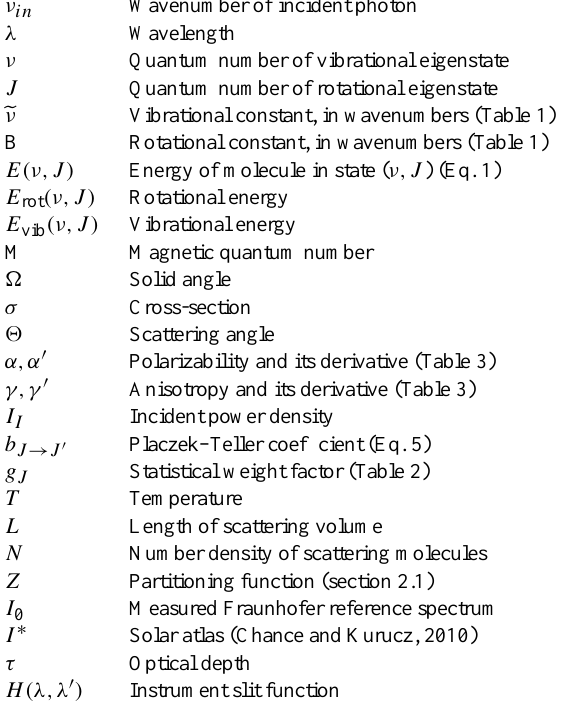
Table 4. Variables used in